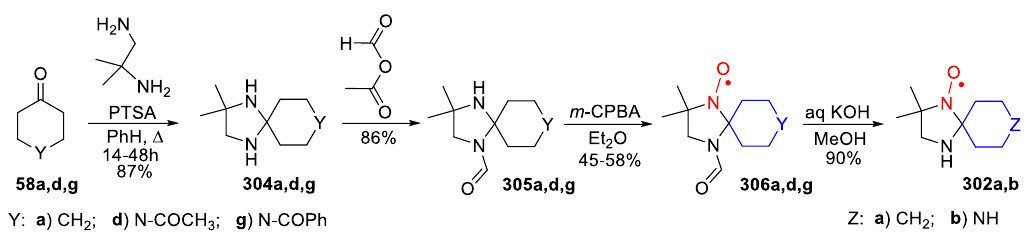
Scheme 54. Synthesis of 5,5-dimethyl–substituted SNRs of imidazolidine. 2,3-diamino-2,3-dimethylbutane, and the resulting imidazolidines 307a,d are oxidized